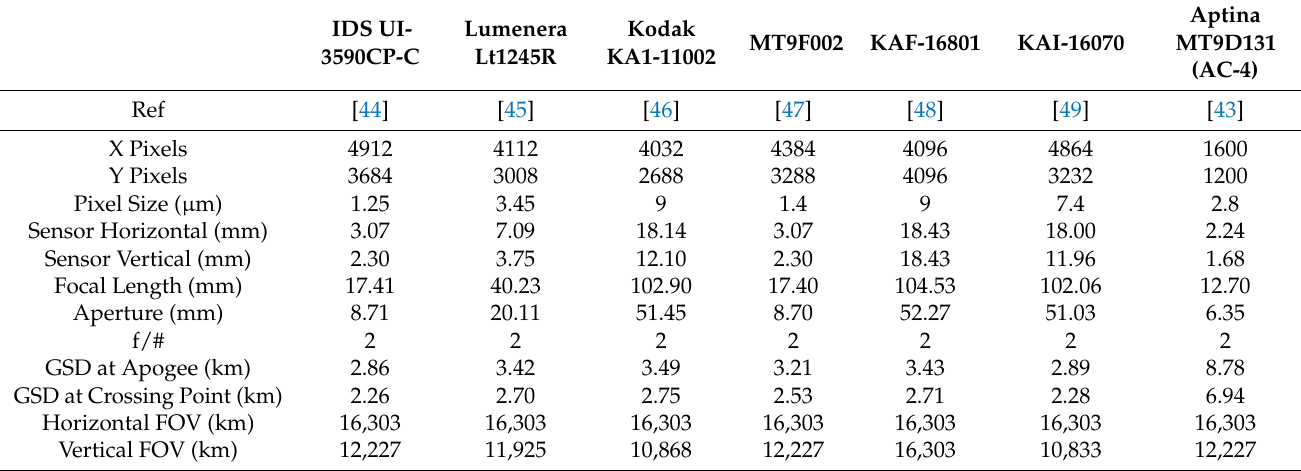
Table 2. Sensor specifications of 4K sensors and their calculated optics parameters for a 20 ◦ FOV in Molniya orbit. The AC-4 Megapixel sensor (Aptina MT9D131 [26]) is also included for